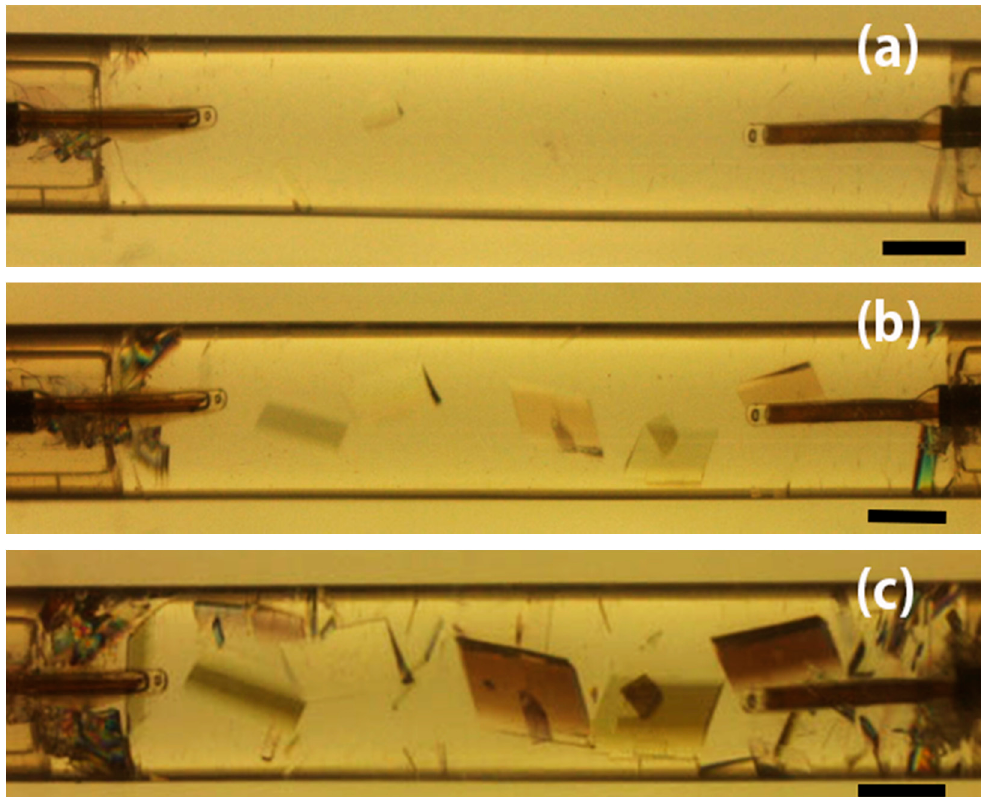
Figure 5. Alpha-amylase crystals grown in the crystallization cell. ( a ) Eighteen days after crystallization set up, three small crystals were observed in the middle of the crystallization cell. ( b ) On Day 19, five 1.16 mm crystals were observed. ( c ) On Day 28, the largest crystals were 1.4 to 1.5 mm. The scale bars correspond to 1 mm. Table 6. Data collection and processing of alpha-amylase